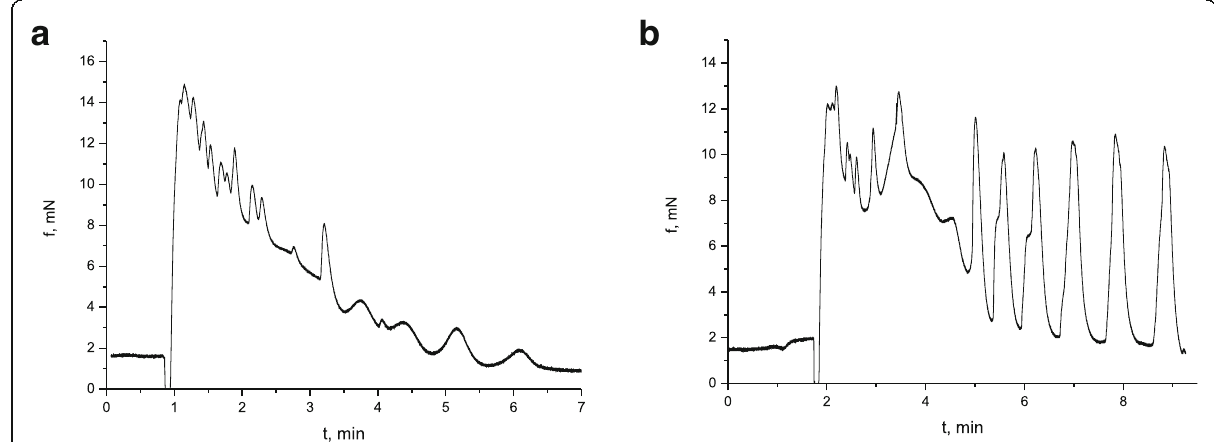
Fig. 8 Oxytocin-induced (0.1 IU) contractions of the myometrium SMS in the presence of glibenclamide (10 − 5 mol/l) and 5-hydroxydecanoate (2·10 − 4 mol/l) ( a ) and the same in the presence of titanium dioxide (10 − 5 mg/ml) ( b